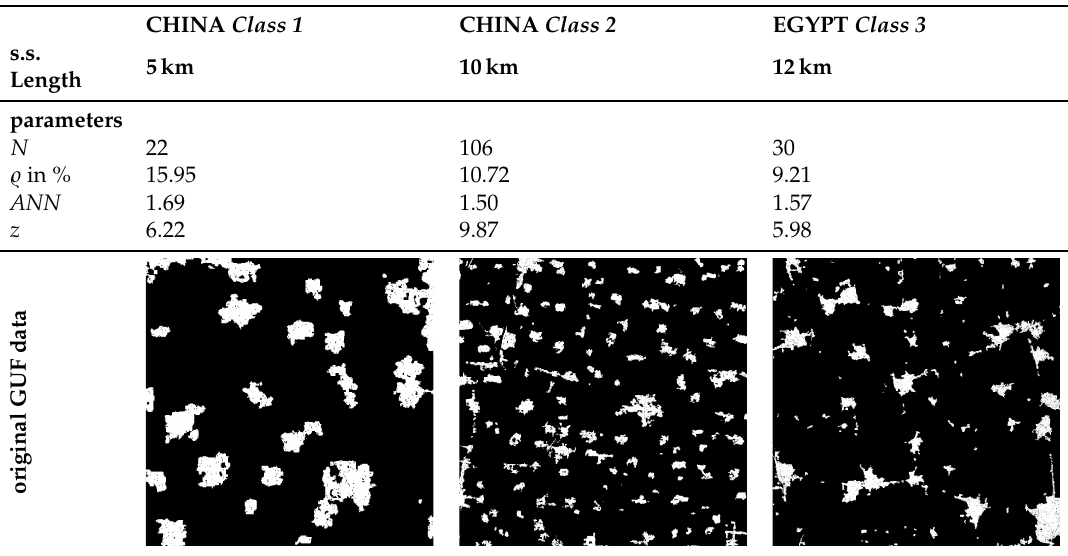
Table 3. Examples for regular settlement structures in the data sets China and